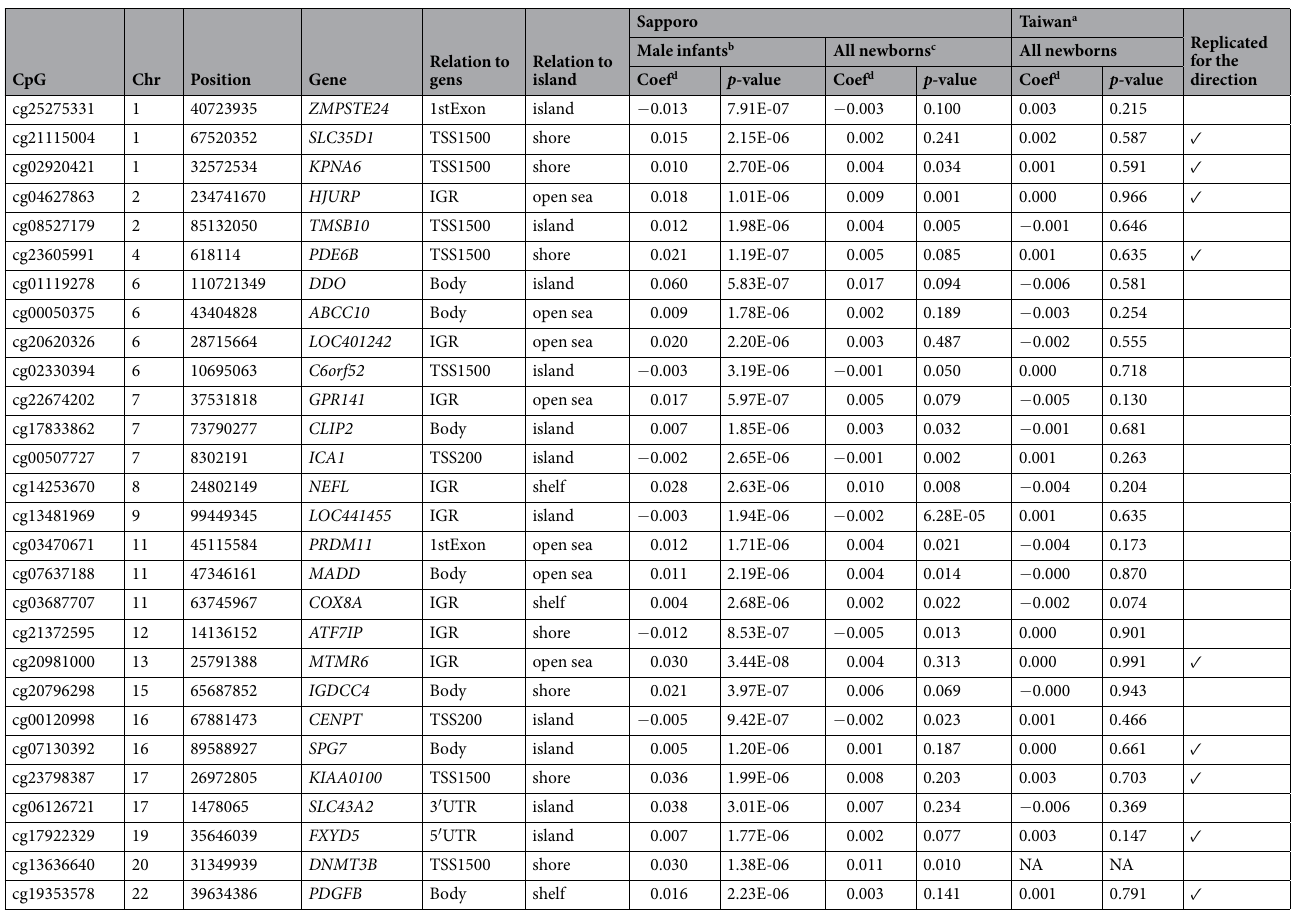
Table 2. 28 CpGs with DNA methylation levels in cord blood associated with BPA concentrations with FDR q < 0.05 in analysis for male infants. a Linear regression analyses adjusted for the sex of child were applied to determine the associations of DNA methylation levels with ln -transformed BPA levels in the Taiwan cohort. b Adjusted for maternal age, maternal educational levels, maternal pre-pregnancy BMI, maternal smoking during pregnancy, gestational age, and cord blood cell estimates. c Adjusted for maternal age, maternal educational levels, maternal pre-pregnancy BMI, maternal smoking during pregnancy, gestational age, infant sex, and cord blood cell estimates. d Partial regression coefficient indicates absolute DNA methylation change per ln-unit increase in BPA concentration. Chr, chromosome; TSS, transcription start site; TSS200, 200 bases from TSS; TSS1500, 1500 bases from TSS; Body; gene body; UTR, untranslated region; NA, not